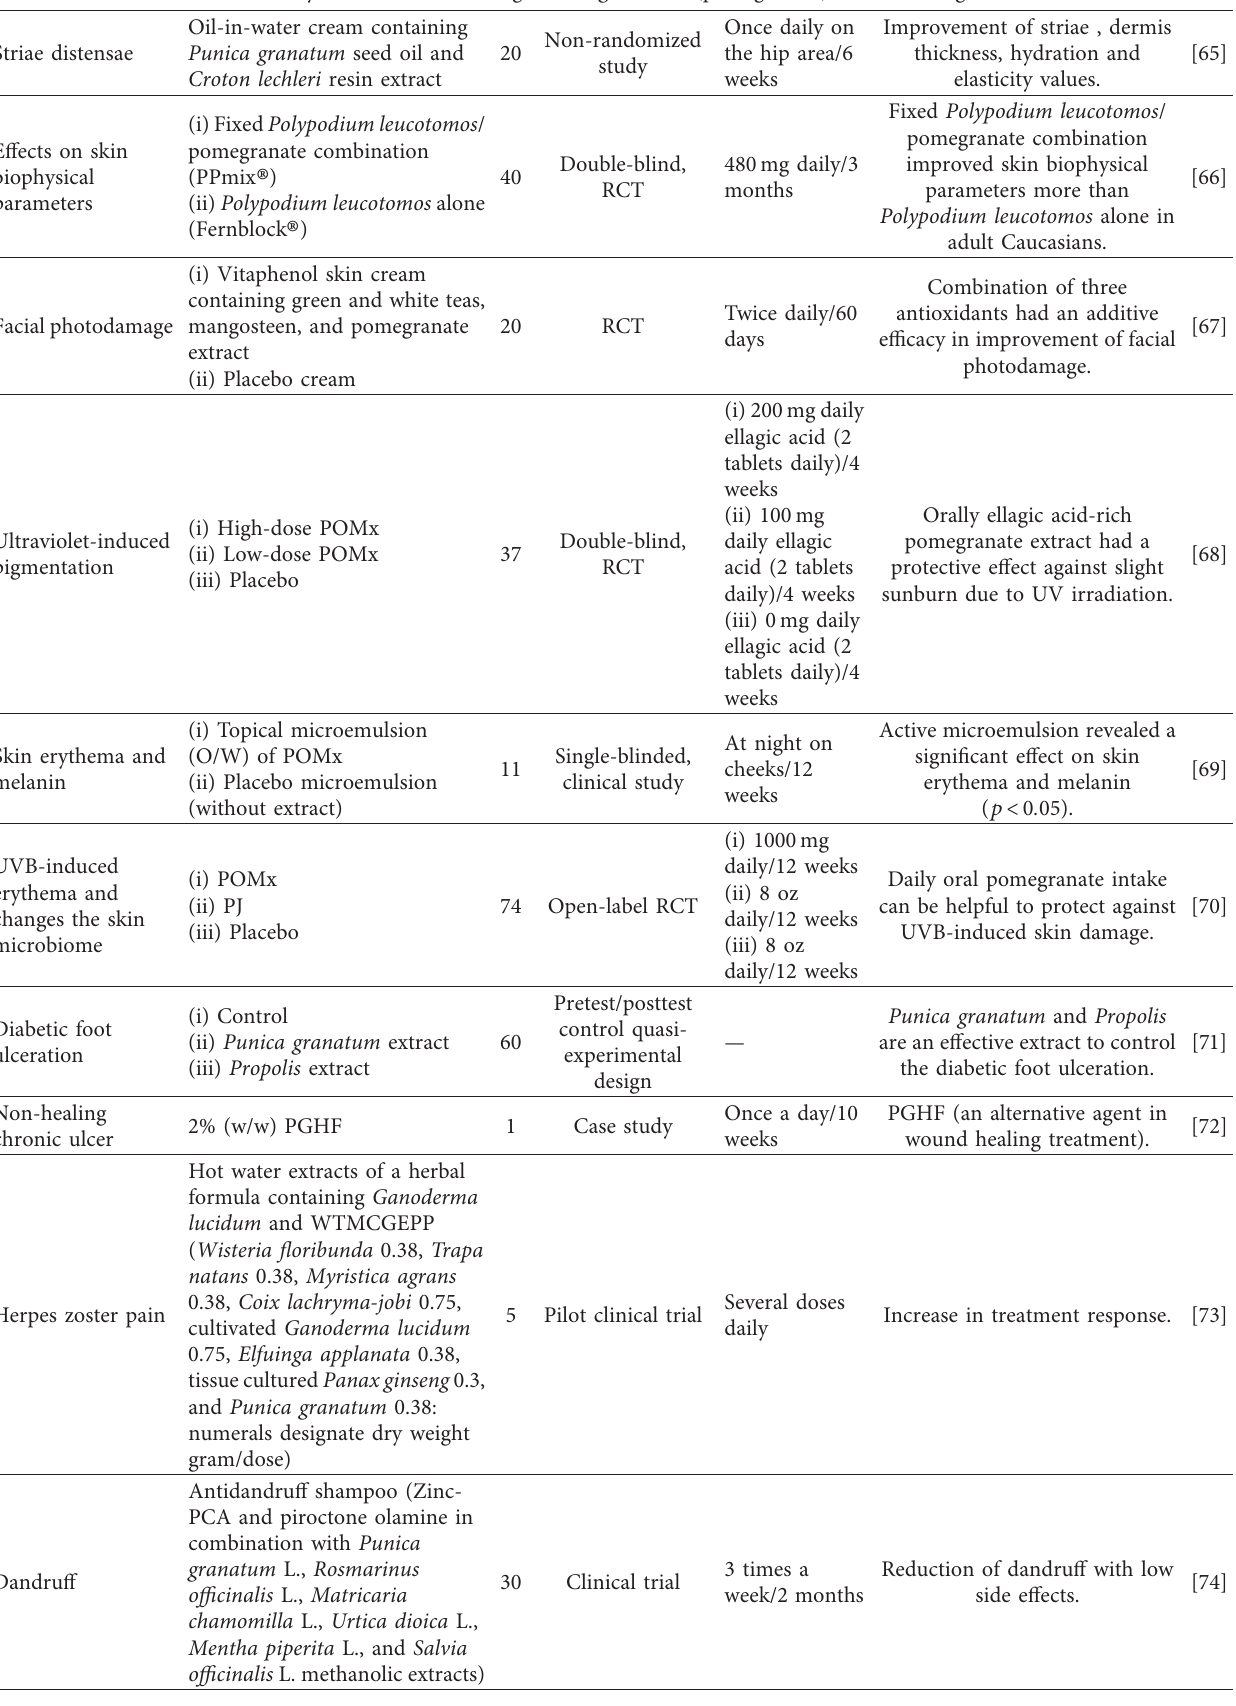
Table 3: Summary of clinical trials using Punica granatum (pomegranate) in dermatologic disorders. Striae